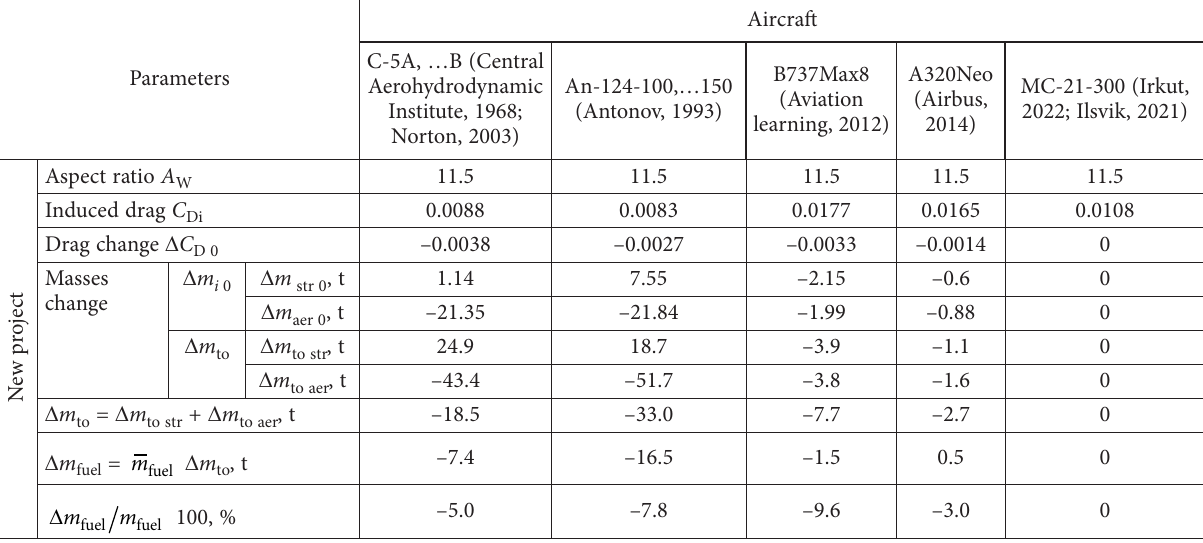
of Table 2. Main parameters of five the transport category aircraft